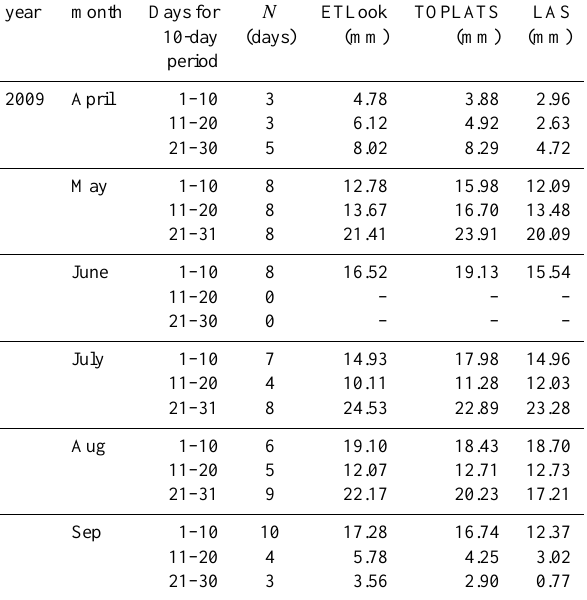
Table 3. Evapotranspiration sums for every 10-day period in the considered six-months period from estimates by ETLook, TOPLATS and LAS. The number of considered days within the 10- day period is indicated by N